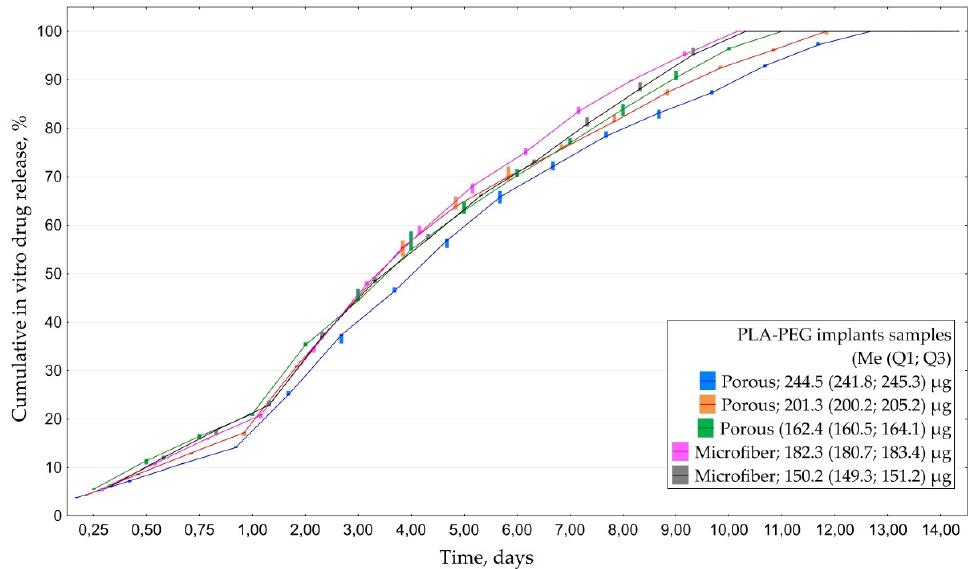
Figure 7 . Cumulative drug release of everolimus from PLA-PEG implants samples depending on their structure and initial drug amount .